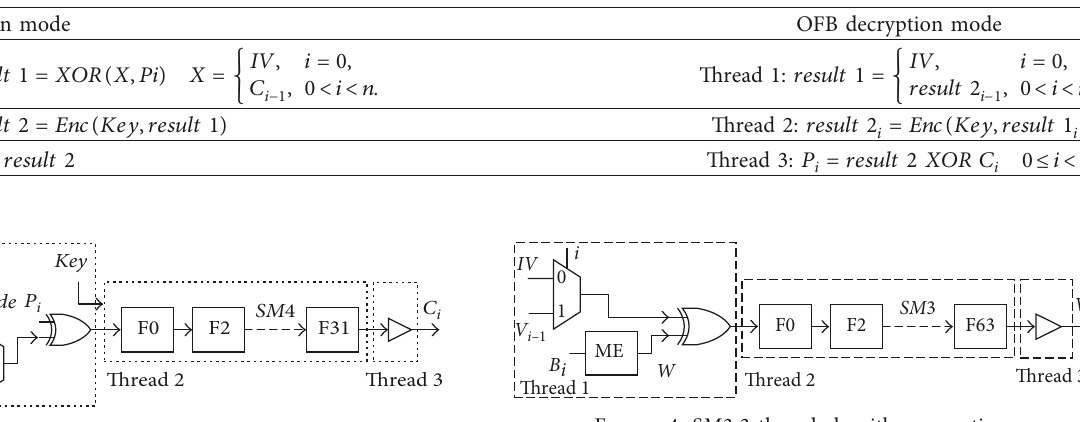
Figure 3: SM4 3-thread algorithm operation.